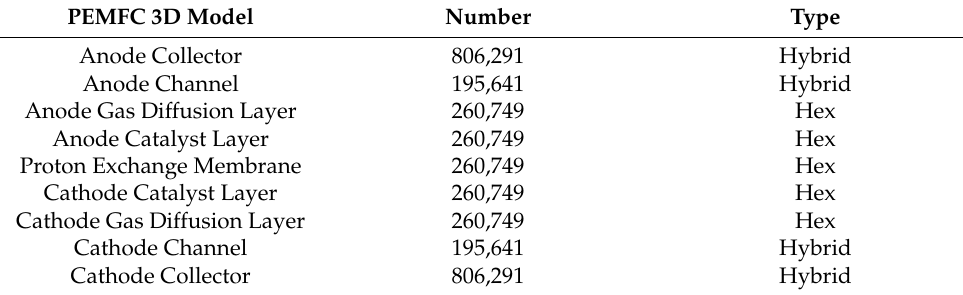
Table 2. The number and type of mesh elements.